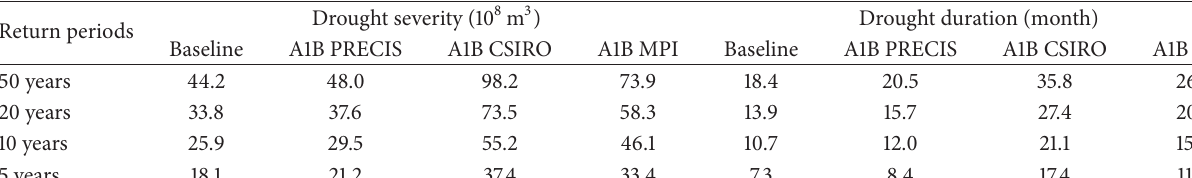
Table 4: Drought characteristics in different univariate return periods under baseline and A1B scenarios.